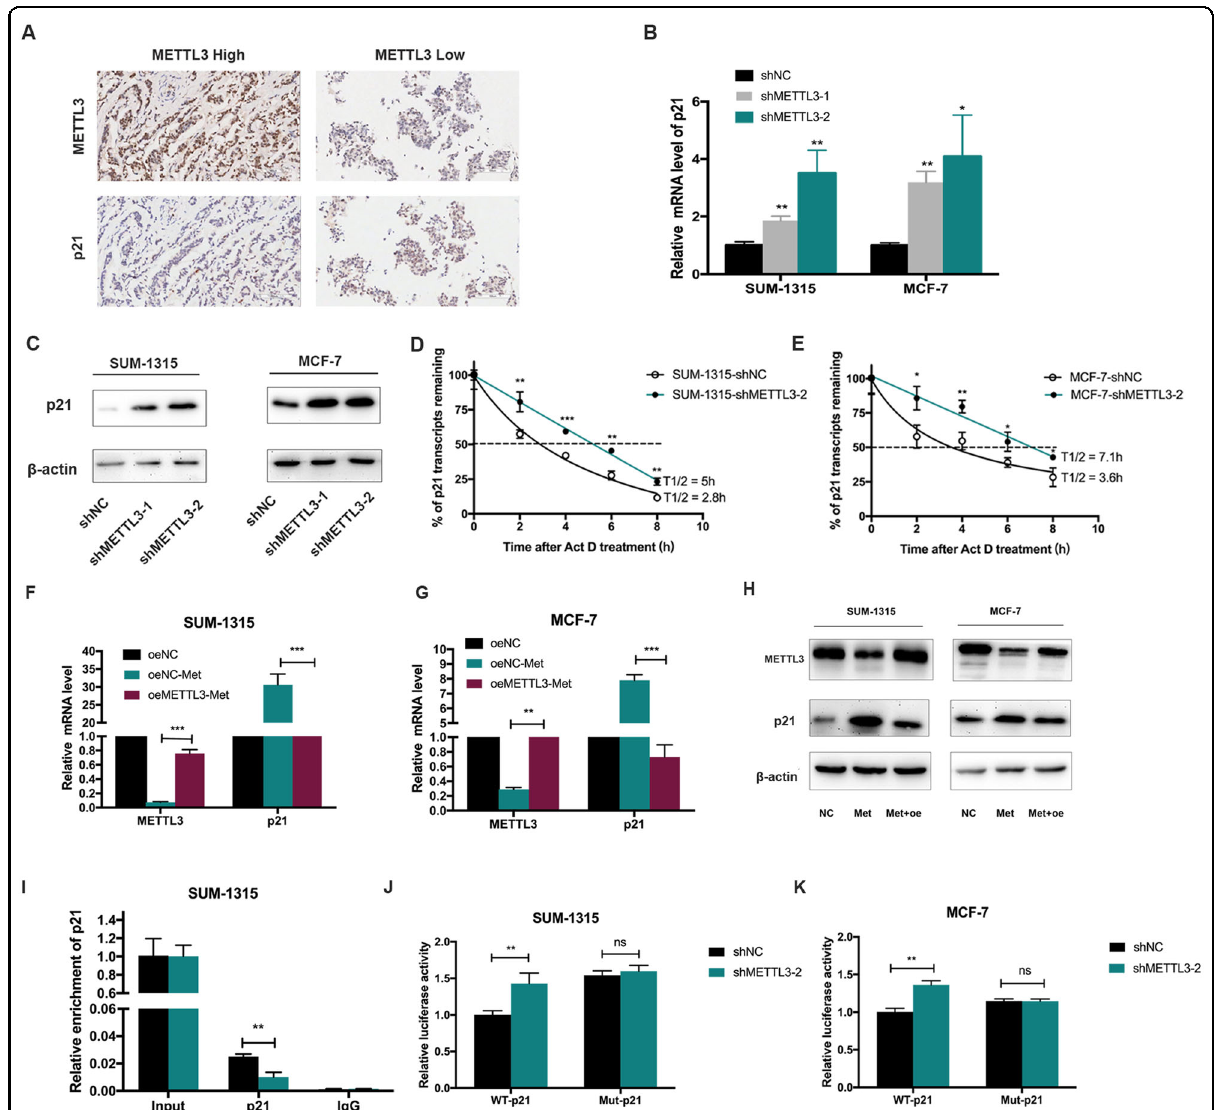
Fig. 4 Metformin upregulated the expression of p21 by reducing METTL3-associated m 6 A modi fi cation. A The breast cancer tissue with the high staining of METTL3 expressed a low level of p21 while the tissue with the low staining of METTL3 expressed a high level of p21. B , C The mRNA and protein expression of p21 was upregulated after METTL3 knockdown in SUM-1315 and MCF-7 cells. The relative RNA level was calculated by the 2 − ΔΔ Ct method and normalized based on β -actin. The average mRNA level of p21 in shNC group was set as 1. D , E Knockdown of METTL3 prolonged the half-life of p21 transcript in SUM-1315 and MCF-7 cells. F – H Overexpression of METTL3 attenuated the regulation of METTL3 and p21 by metformin both in mRNA and protein level in SUM-1315 and MCF-7 cells. The relative RNA level was calculated by the 2 − ΔΔ Ct method and normalized based on β -actin. The average mRNA level of METTL3 and p21 in oeNC group was set as 1. ** p <0.01, *** p <0.001 vs. oeNC-Met group. I MeRIP followed by qRT-PCR showed that METTL3 knockdown could decrease the amount of p21 mRNA modi fi ed by m 6 A. The relative enrichment level of p21was calculated by the 2 − Δ Ct method and normalized based on Input. ** p <0.01 vs. shNC grou p . J , K After METTL3 knockdown, luciferase activity of wild-type 3 ′ -UTR of p21 was increased in SUM- 1315 and MCF-7 cells while mutant abolished this induction. ** p <0.01 vs. shNC group, ns means not signi fi cant. shNC, scramble control; shMETTL3 1/2, METTL3 knockdown; oeNC, negative control; oeNC-Met, oeNC-Met negative control group treated with metformin; oeMETTL3-Met, METTL3 overexpression group treated with metformin; WT-p21, wild-type 3 ′ -UTR of p21, Mut-p21, mutant-type 3 ′ -UTR of p21. Data represented the